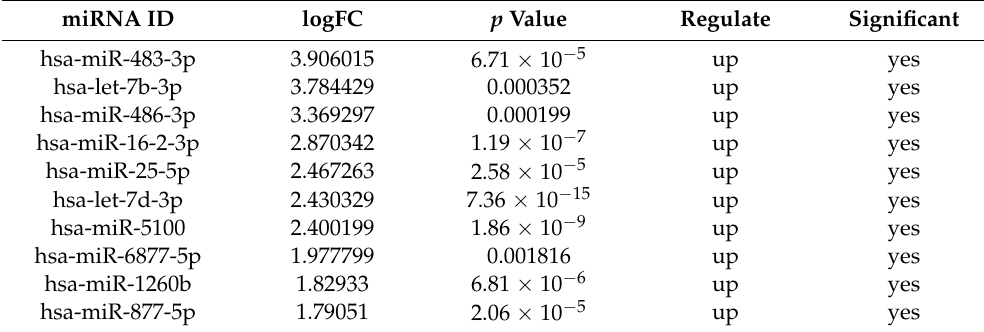
Figure 2. Differentially expressed miRNAs profiles. The heatmap (cluster analysis) was used to detect the significant differentially expressed miRNAs ( A ). Red represents high expression and blue represents low expression of miRNAs. Volcano plots were used to assess the miRNAs ( B ) expression variation. The values of X - and Y -axes in the scatter plot are averaged normalized values of each sample. Fold change ≥ 2, p < 0.05. Table 3. The top 10 up-regulated miRNAs in leishmaniasis patients compared to healthy control